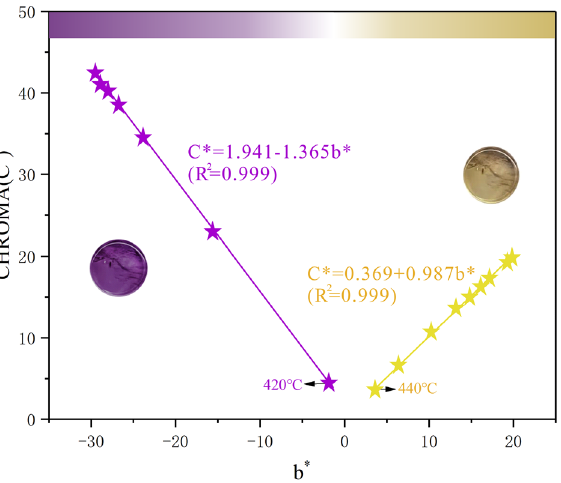
Figure 6. The relationship between b* and C* at different temperatures. The figure was drawn using the OriginPro 2017C Beta b9.4.1.268 (https ://www.Origi